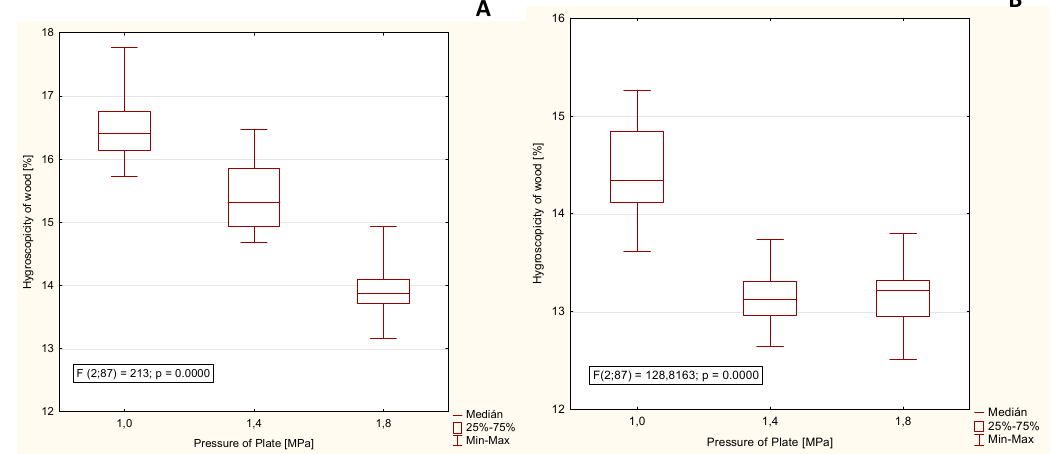
Figure 11. Effect of plate pressure on the resulting value of wood hygroscopicity for the ( A ) radial and ( B ) tangential samples.